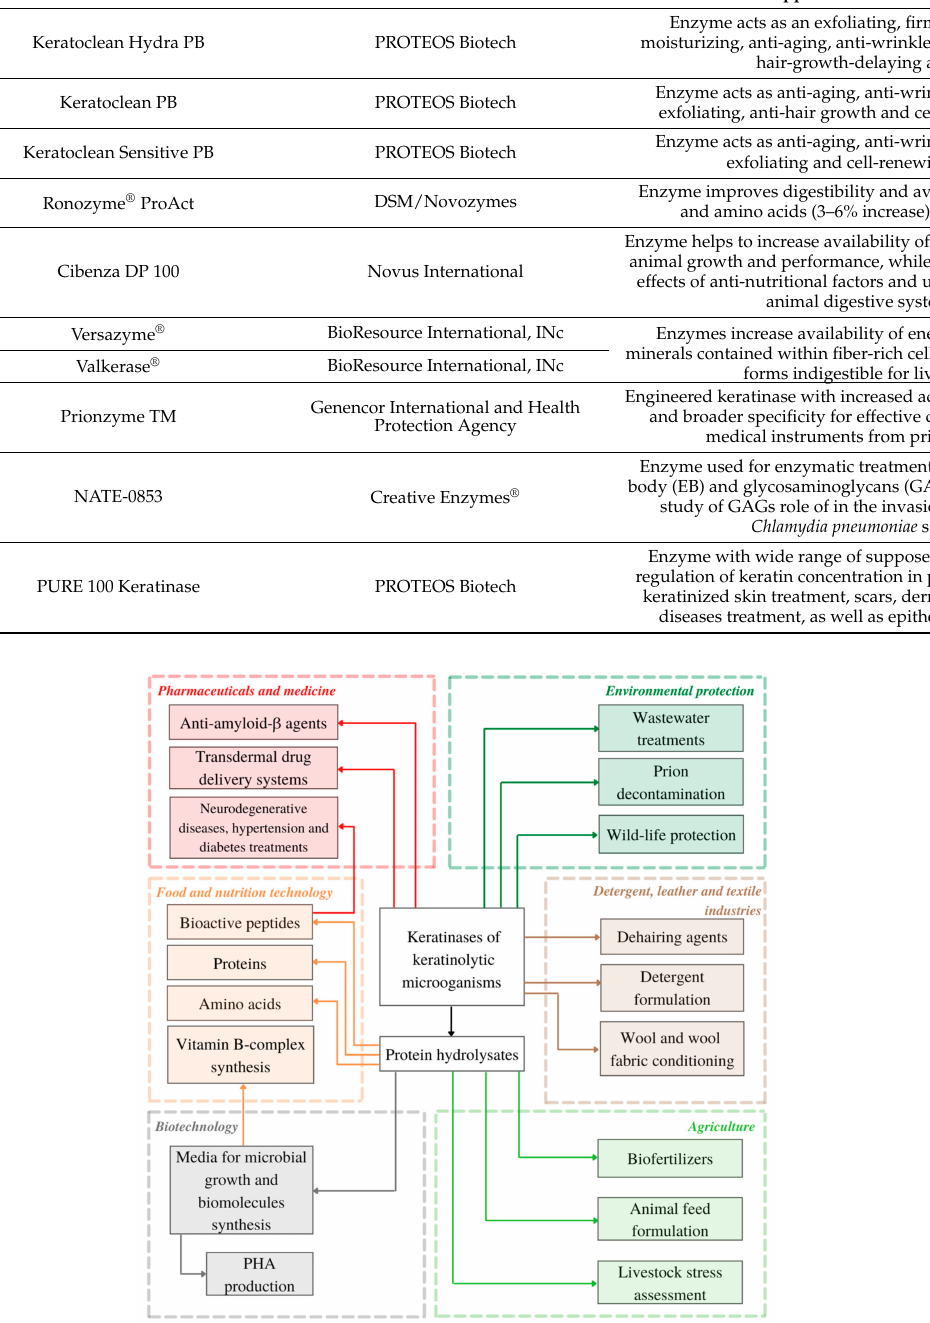
Figure 2. Present and potential applications of keratinolytic microorganisms and keratinases re- viewed in this article